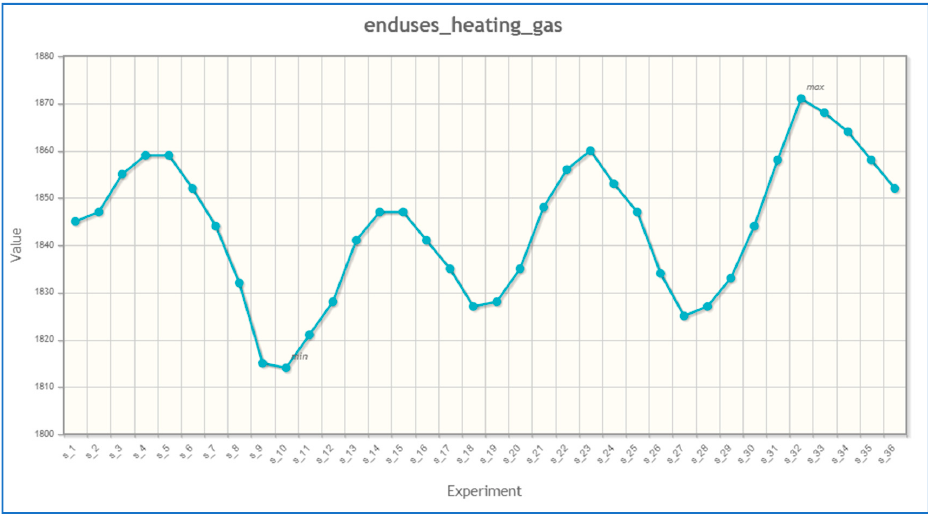
Figure 3. Example of numerical results of the energy consumption depending on the building orientation obtained directly from the model output.